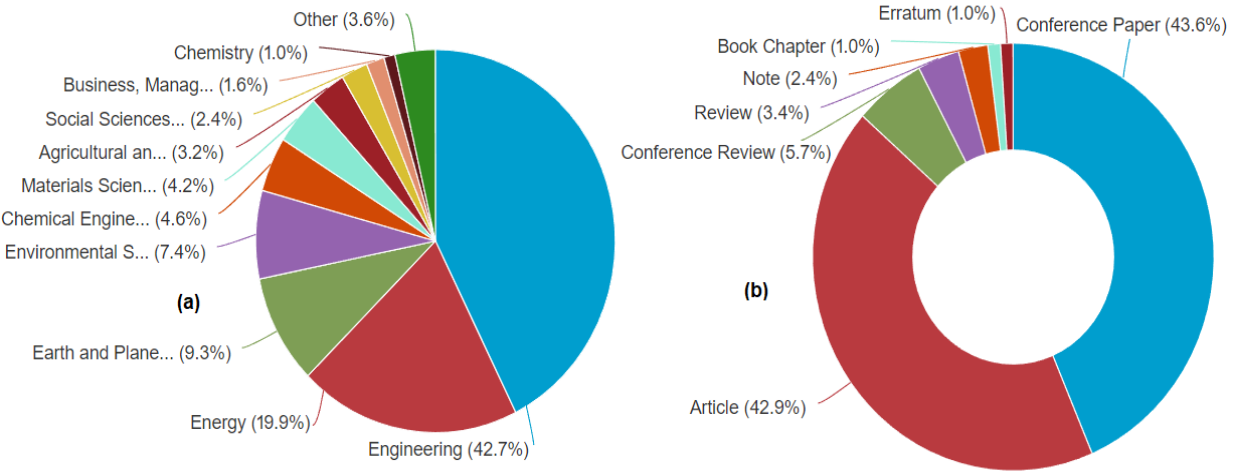
Figure 5. The research on “marine hose” showing ( a ) subject area and ( b ) document type (data retrieved from Scopus database, 24 July 2022).